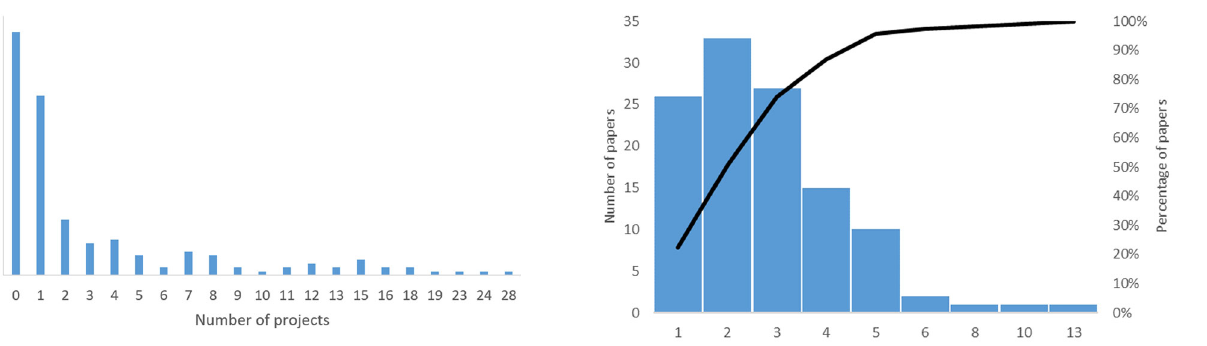
Fig. 9 Number of articles indexed in Scopus acknowledging funding.